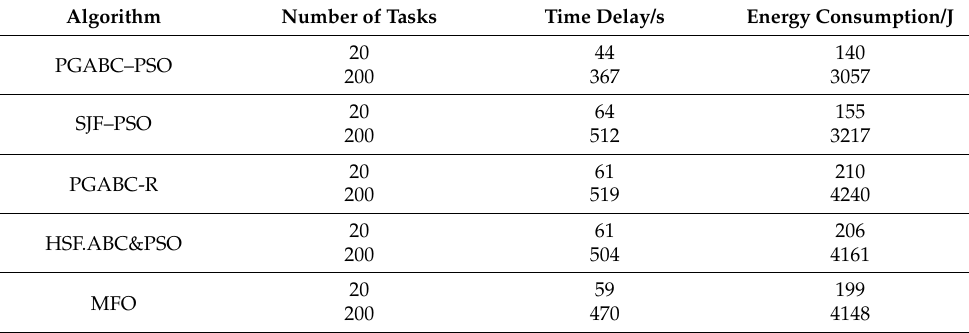
Figure 10. Total system energy consumption for the five schemes varying with task number. Table 4. The delay and energy consumption of the five strategies when the number of tasks was 20 or 200 and the fog node was